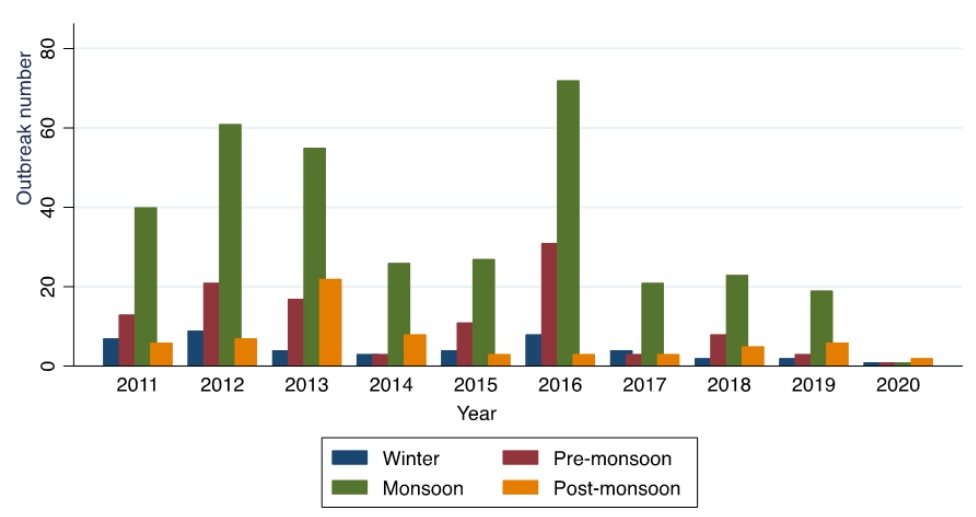
Figure 4. Cholera outbreaks ( n = 565) by year and season, India, 2011–2020. Winter = December to January; Pre ‐ monsoon = March to May; Monsoon = June to September; and Post ‐ monsoon = Octo ‐ ber to November.